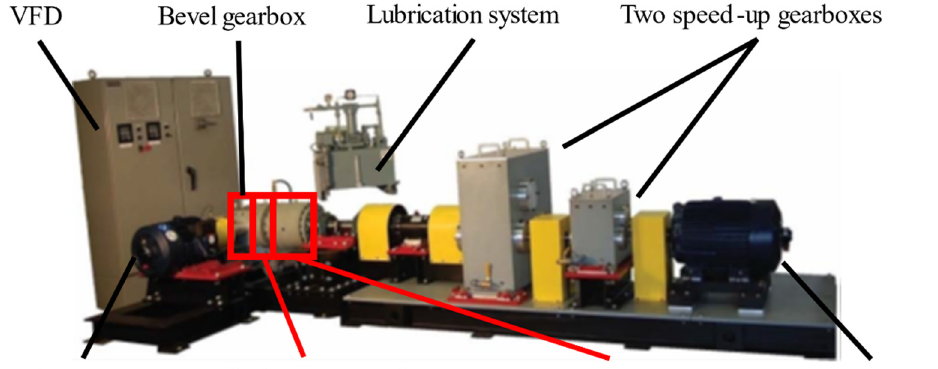
Figure 3. Planetary gearbox test rig [14]. Table 1. The number of teeth and reduction ratio of each gearbox in the test rig.